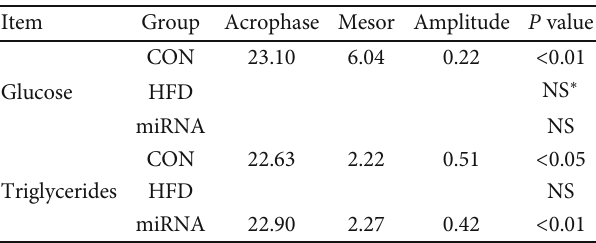
Table 3: Mesor, amplitude, and acrophase of glucose and triglycerides in the serum of mice.